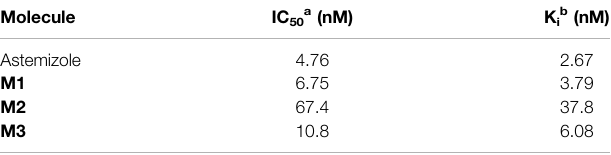
TABLE 3 | Af fi nity of probes for hERG-transfected HEK293. Molecule IC 50a (nM)